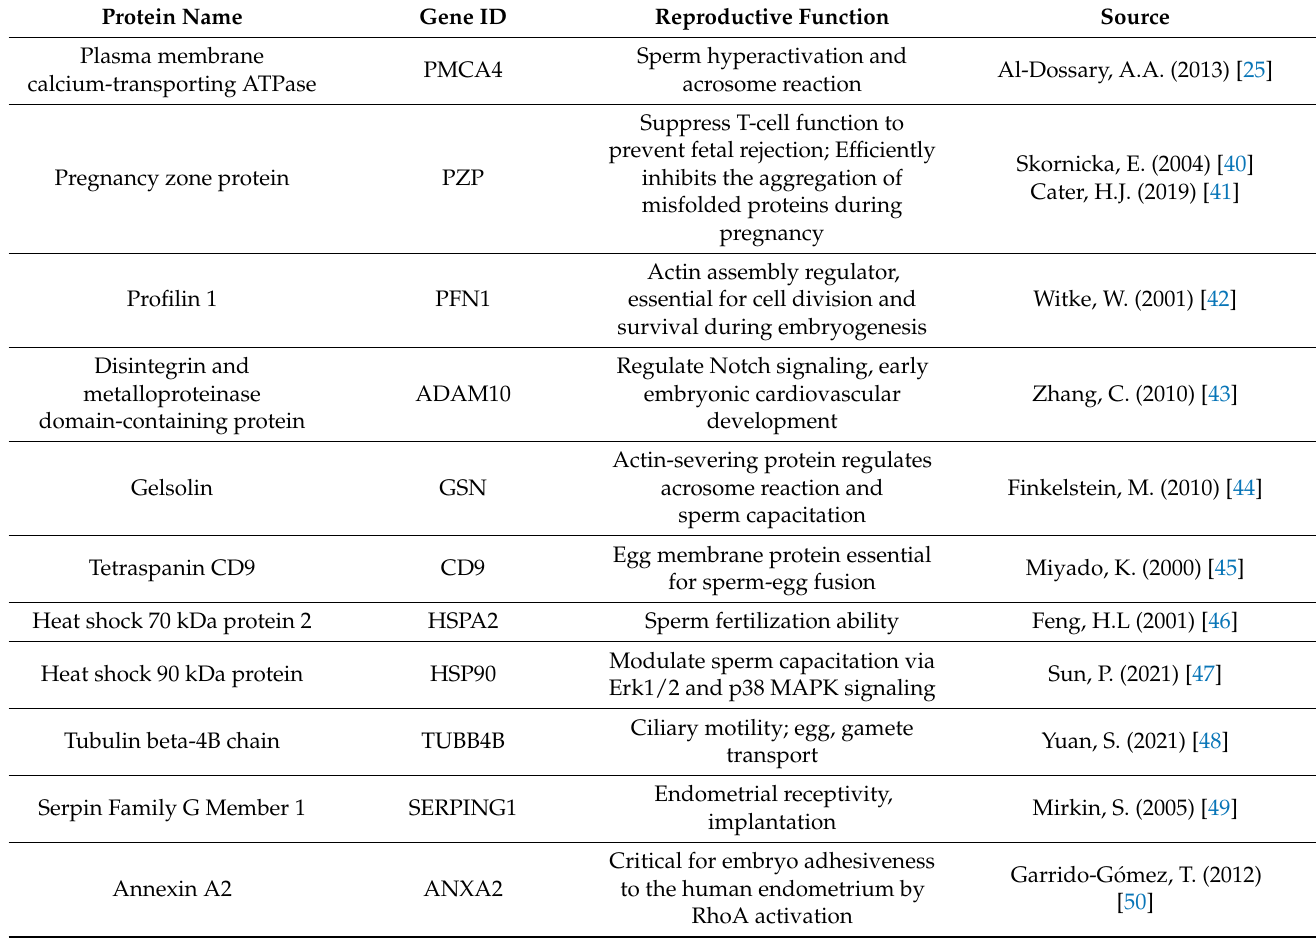
Table 1. The list of proteins among the 295 identified human fallopian tube epithelial (hFTE) sEV proteins with known functions in reproductive biology.